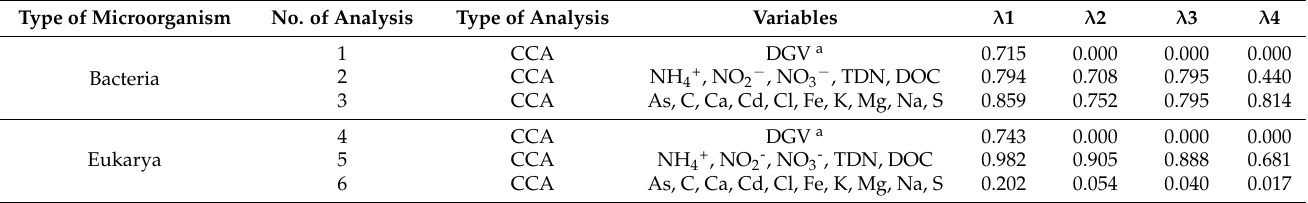
Table 3. Summary of canonical correspondence analysis and